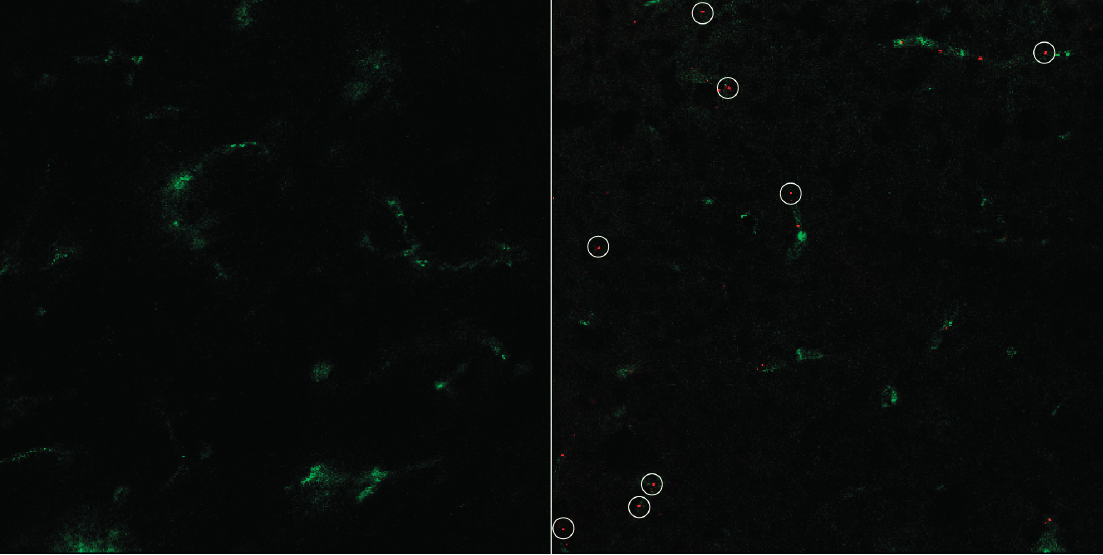
Figure 7. Exemplary image of rat brain cryosection after 6 h of cBSA-liposome incubation ( right ) with control ( left ). Capillaries have been stained with FITC-BSA (green). Liposomal rhodamine B (red).